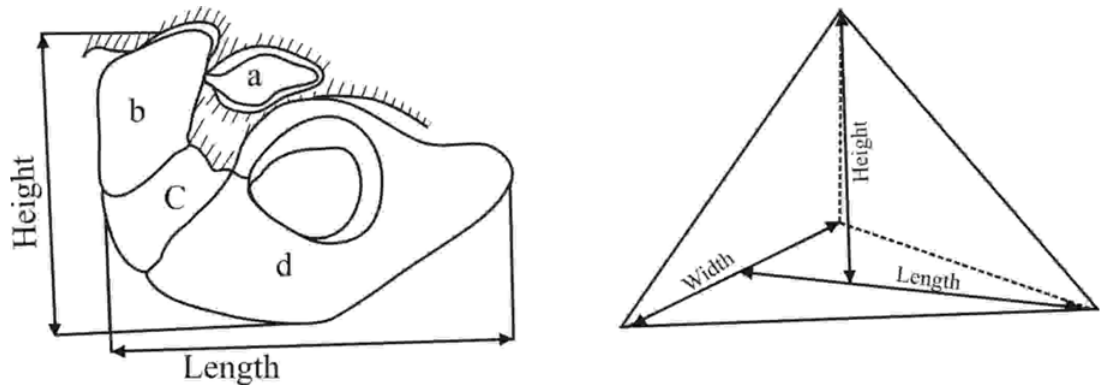
F IG . 4.- (Left): Tympanic bulla shape, a: suprameatal triangle (Petter, 1968) or mastoid anterior part (Lay, 1972), b and c: upper and lower posterior mastoid (Lay, 1972), d: sympatic (Lay, 1972) (Right): how to measure characters of tympanic bulla in M. libycus